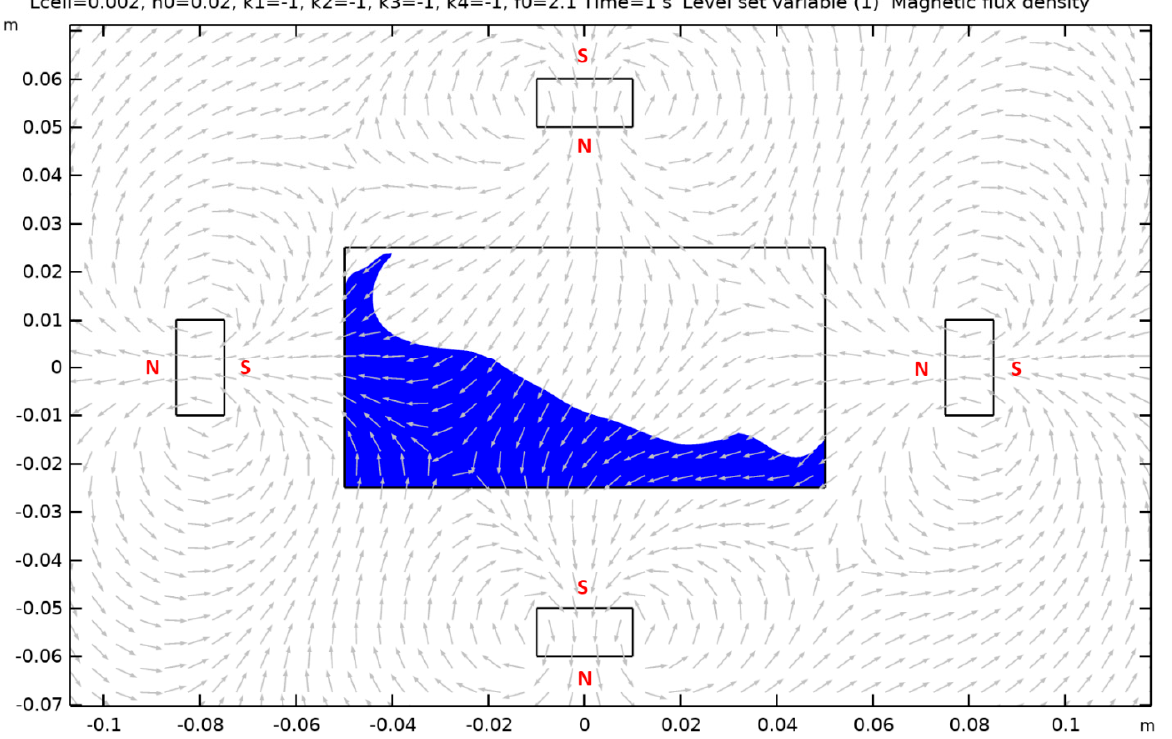
Figure 10. Surface evolution and magnetic flux density arrow surface for case 1, near resonance frequency for L = 10 cm tank.